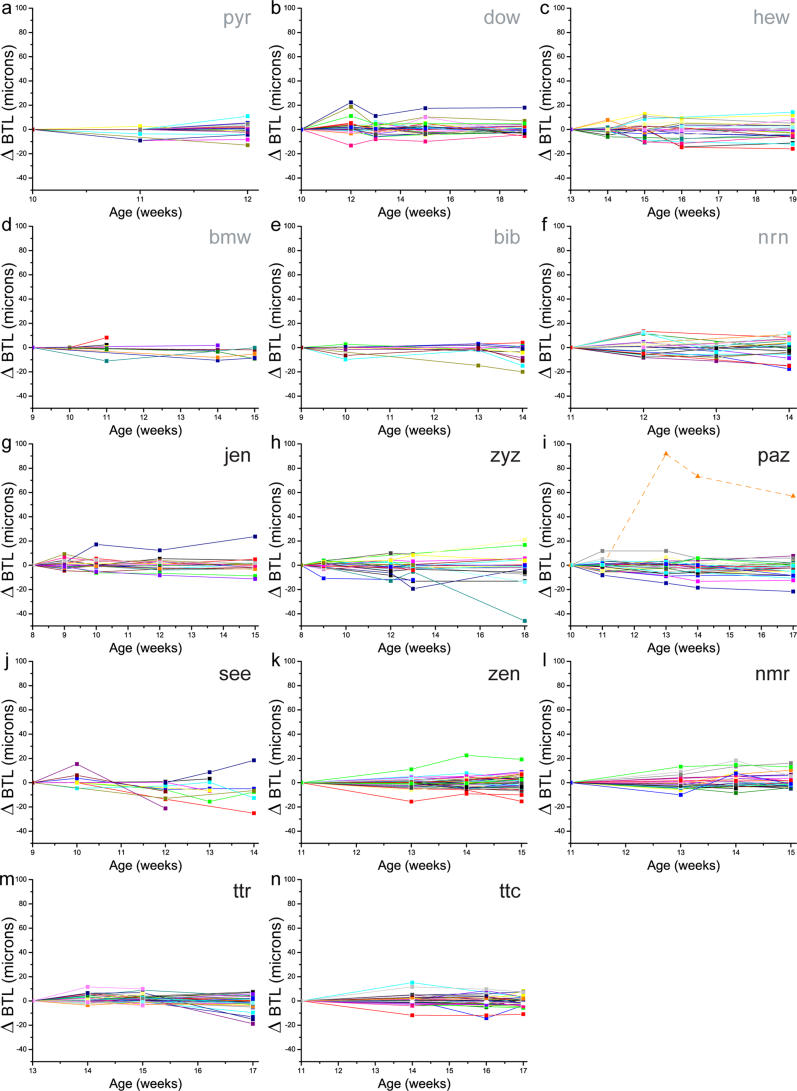
The Change in BTL is Plotted for Each Individual Monitored Branch Tip of Every Imaged CellThree-letter code, top right.(A–F) pyramidal cells; (G–N) non-pyramidal cells. Triangles and dashed lines denote the minimum length of the branch tip as it exceeds the border of the imaging volume.